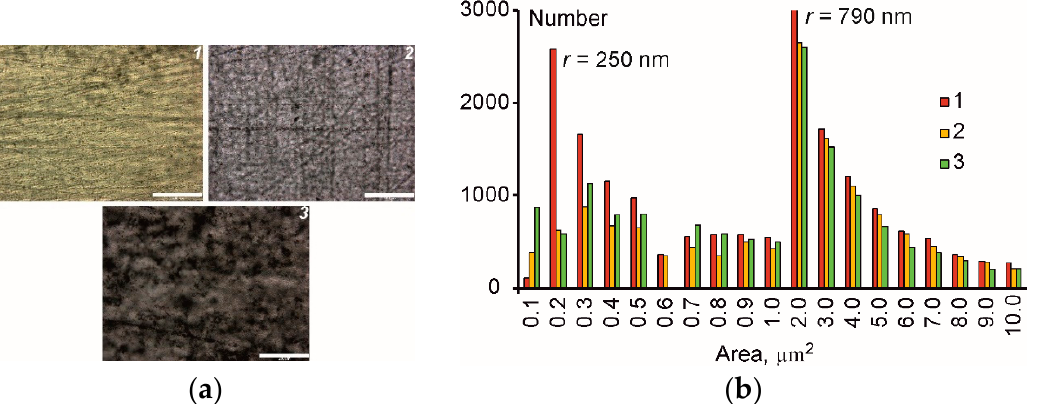
Figure 2. ( a ) Representative optical images (scale: 200 μ m); ( b ) size distribution for the epoxy filled with CNT ( 1 ), CNF ( 2 ), and HN ( 3 ). The filler content was 0.1 wt. % for all PNC.